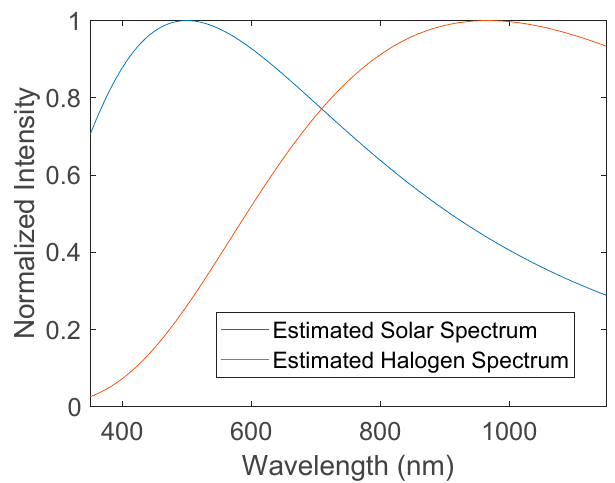
Figure 3. Halogen and solar intensity as a function of wavelength.